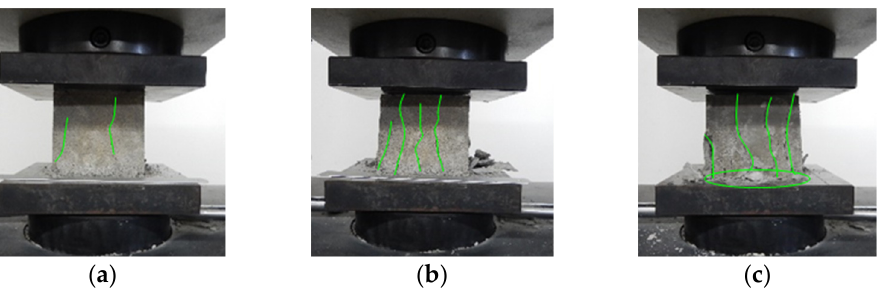
Figure 2. Quasi-static compression and failure process of foamed concrete: ( a ) Microcracks; ( b ) Vertical through cracks; ( c ) Large area cracks and bottom crushing.